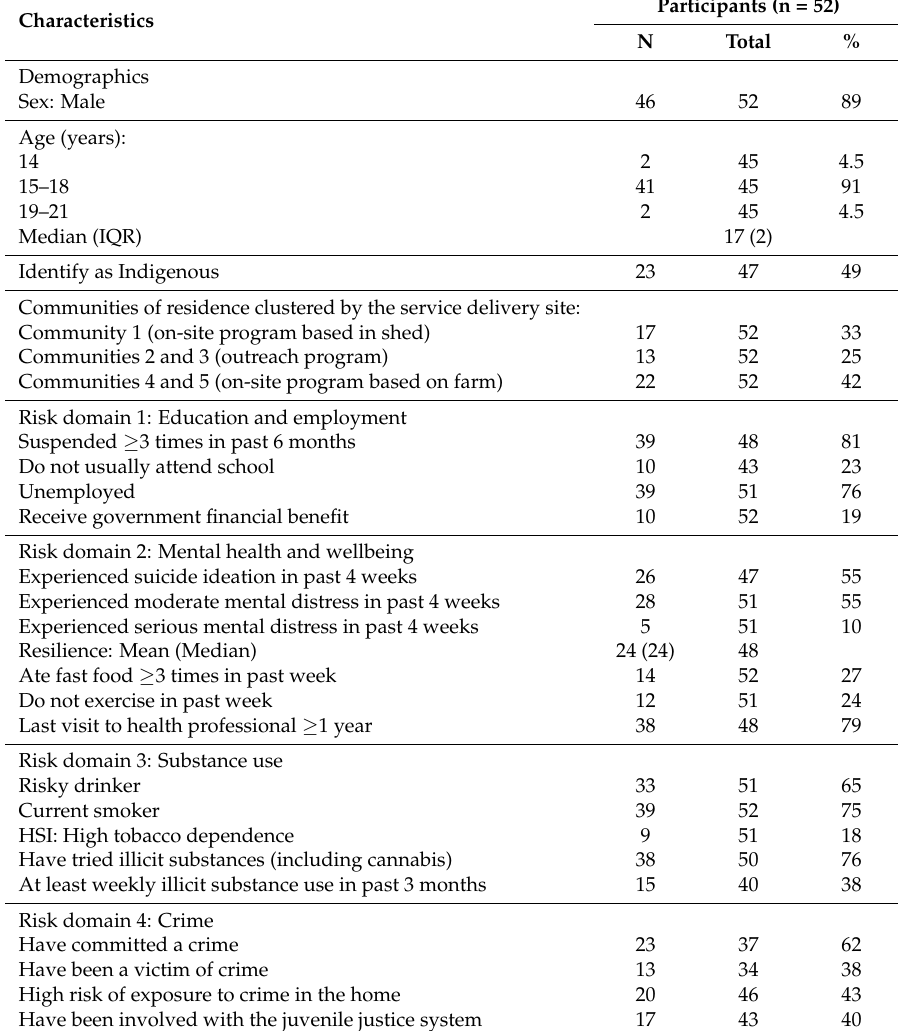
Table 2. Demographic characteristics and risk factors of